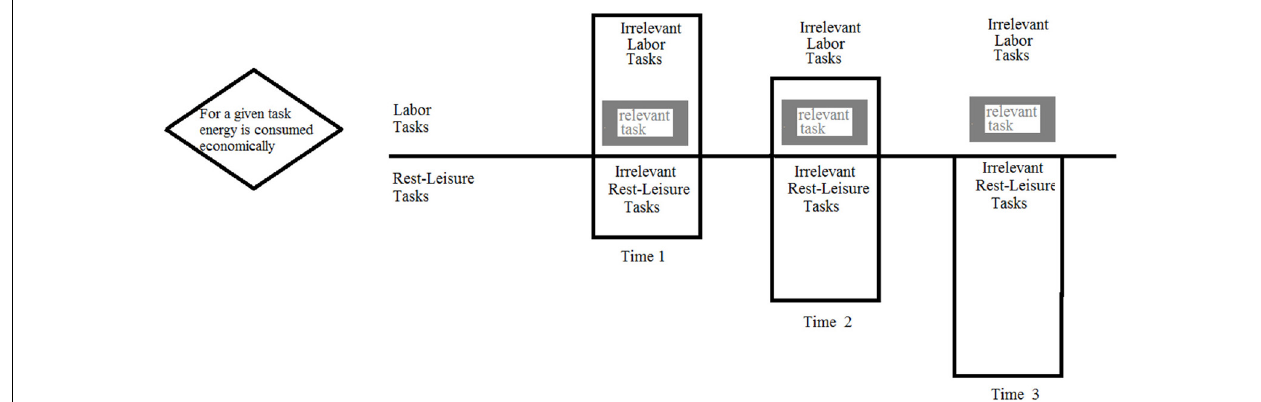
FIGURE 1 | An illustration of how the cognitive system may spread its